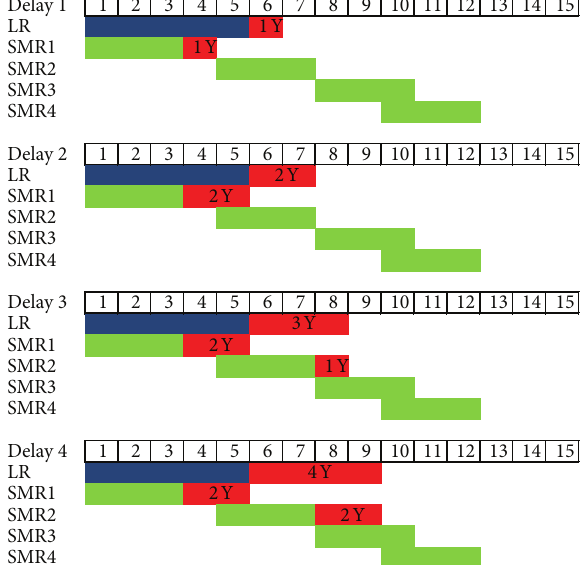
Figure 6: “Intrinsic” delay in the construction schedule considered in the sensitivity analysis: in red, the years of delay in the construc-